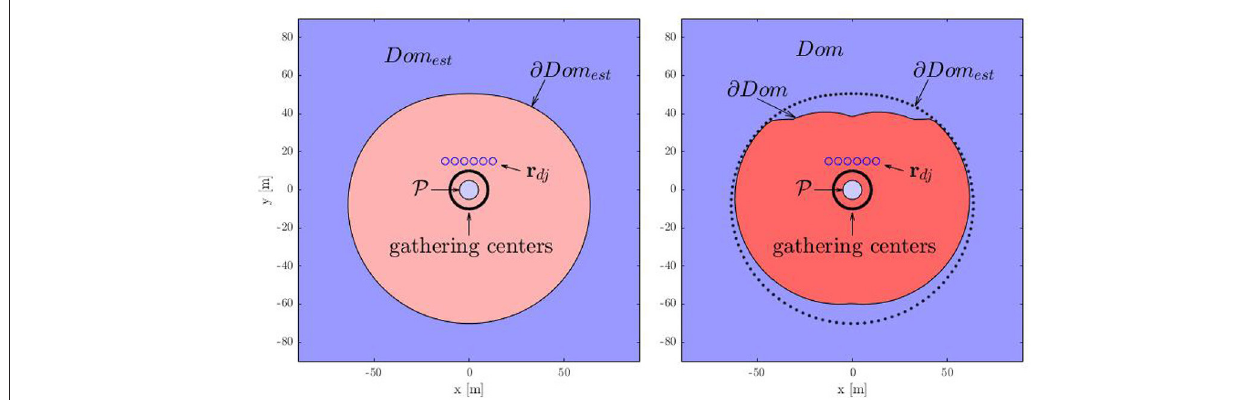
FIGURE 8 | Dominance regions of the players.